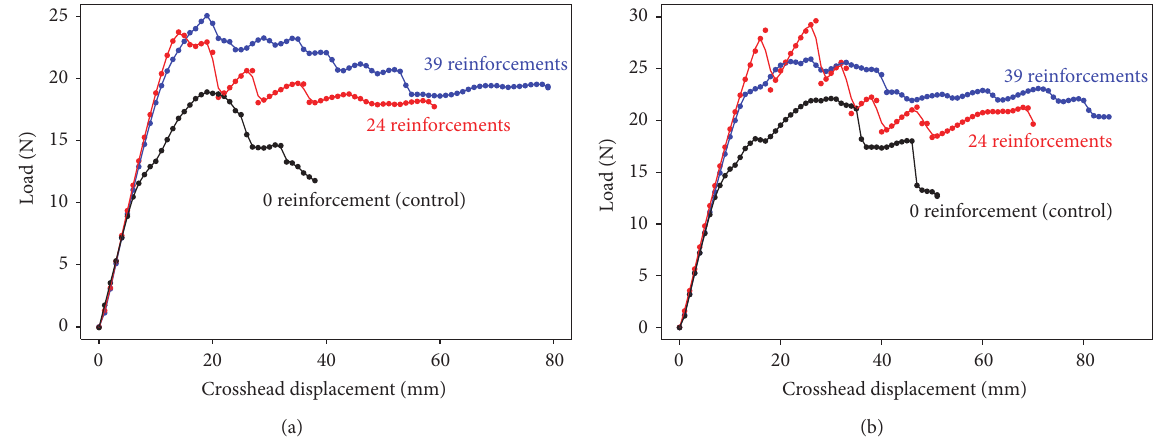
Figure6: Load-displacement curvesofspecimens withdifferent levels ofthrough-reinforcementand bondedusingunmodified polyurethane (PU) adhesive (a) or a glass-fibre reinforced PU (b).